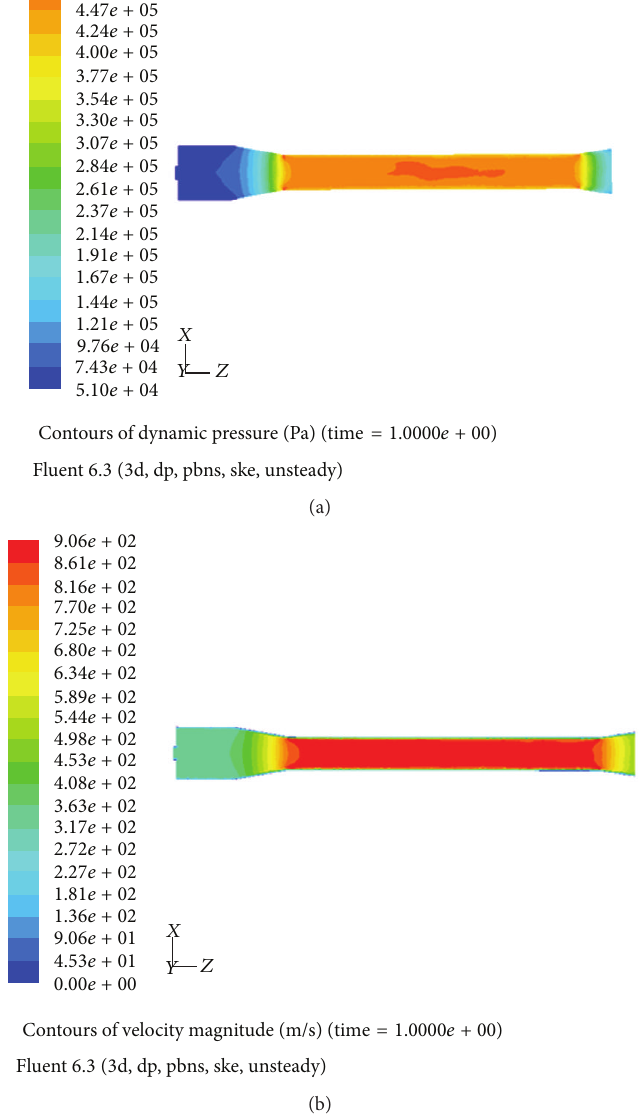
Figure 16: Detonation wave (a) dynamic pressure and (b) velocity flow field contours analysis at Ma = 1 [131].